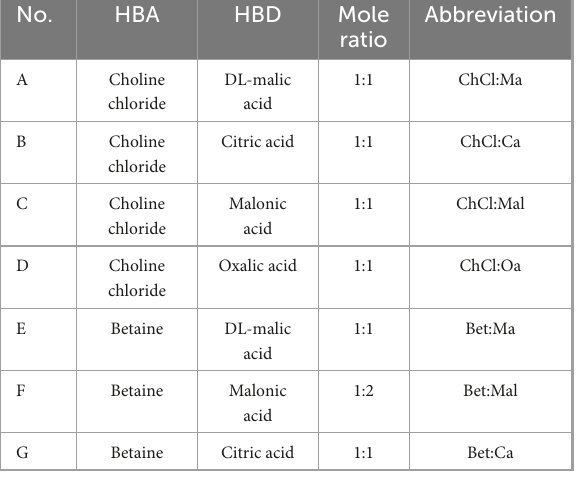
TABLE 1 Different types of natural deep eutectic solvents (NADESs).